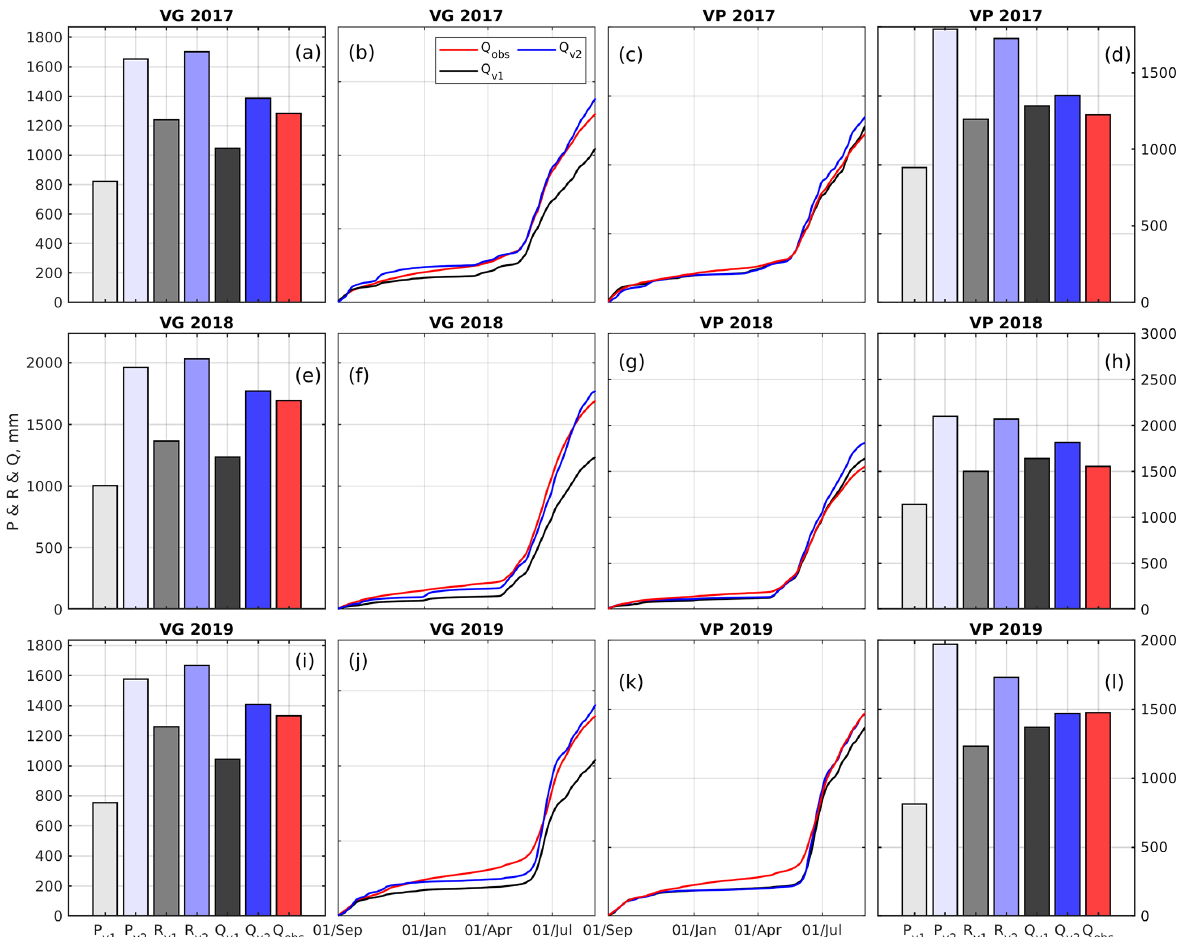
Figure 8. Water balance evaluation of Flood-PROOFS simulations driven by GRISO1 vs. those driven by GRISO2. (a, e, i) A comparison at Beauregard (VG) between annual precipitation ( P ), equivalent precipitation ( R ), and streamflow ( Q ), according to GRISO1 and GRISO2 (v1 and v2, respectively). (d, h, l) A similar comparison at Valpelline (VP). Panels (b–c) , (f–g) , and (j) and (k) compare observed daily cumulative reconstructed streamflow with simulated streamflow using GRISO1 or GRISO2. Equivalent precipitation is the sum of rainfall, snowpack runoff, and glacier runoff. Simulations were carried out in full-Assim mode (see Sect.